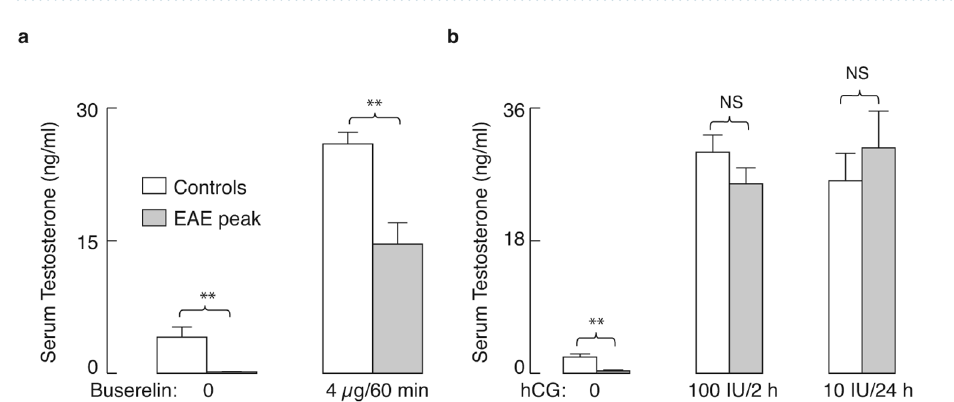
Figure 5. Effects of EAE on basal and stimulated serum testosterone levels. ( a ) Controls (white bars) and peak EAE animals (gray bars) were injected intraperitoneally with saline (left panel) or 4 µg buserelin acetate, a GnRHR agonist (right panel) and blood was collected 1 h after injection. ( b ) Controls (white bars) and peak EAE rats (gray bars) were injected subcutaneously with saline (left panel), 100 IU hCG for 2 h (middle panel), or 10 IU hCG for 24 h (right panel). The results are presented as mean ± SEM (n = 6 animals/group). Statistical evaluation between pairs was determined by Mann-Whitney test. * P < 0.05, ** P < 0.01, NS, nonsignificant.The figure was made using KaleidaGraph (version 4.1.0; http:// www. syner gy. com) and Illustrator (version 25.1.0; http:// www. adobe.